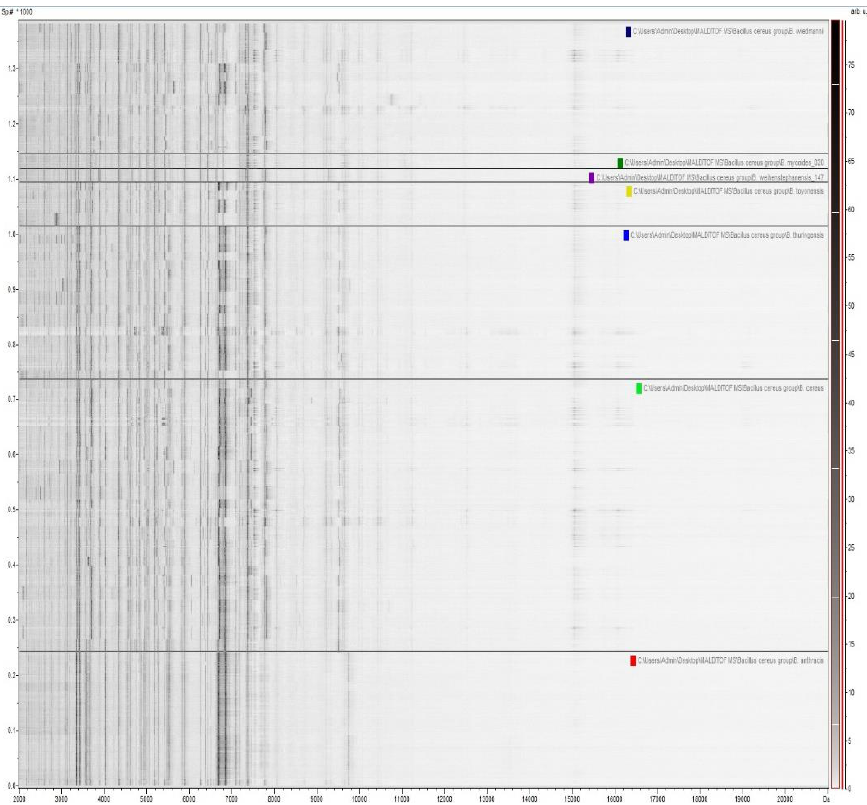
Figure 2. Gel view representation of mass spectra from the B. cereus group strains in the mass range of 2 to 20 kDa, tested in this study. The intensities of MALDI-TOF mass spectra are grey scaled and plotted as functions of the m / z values.